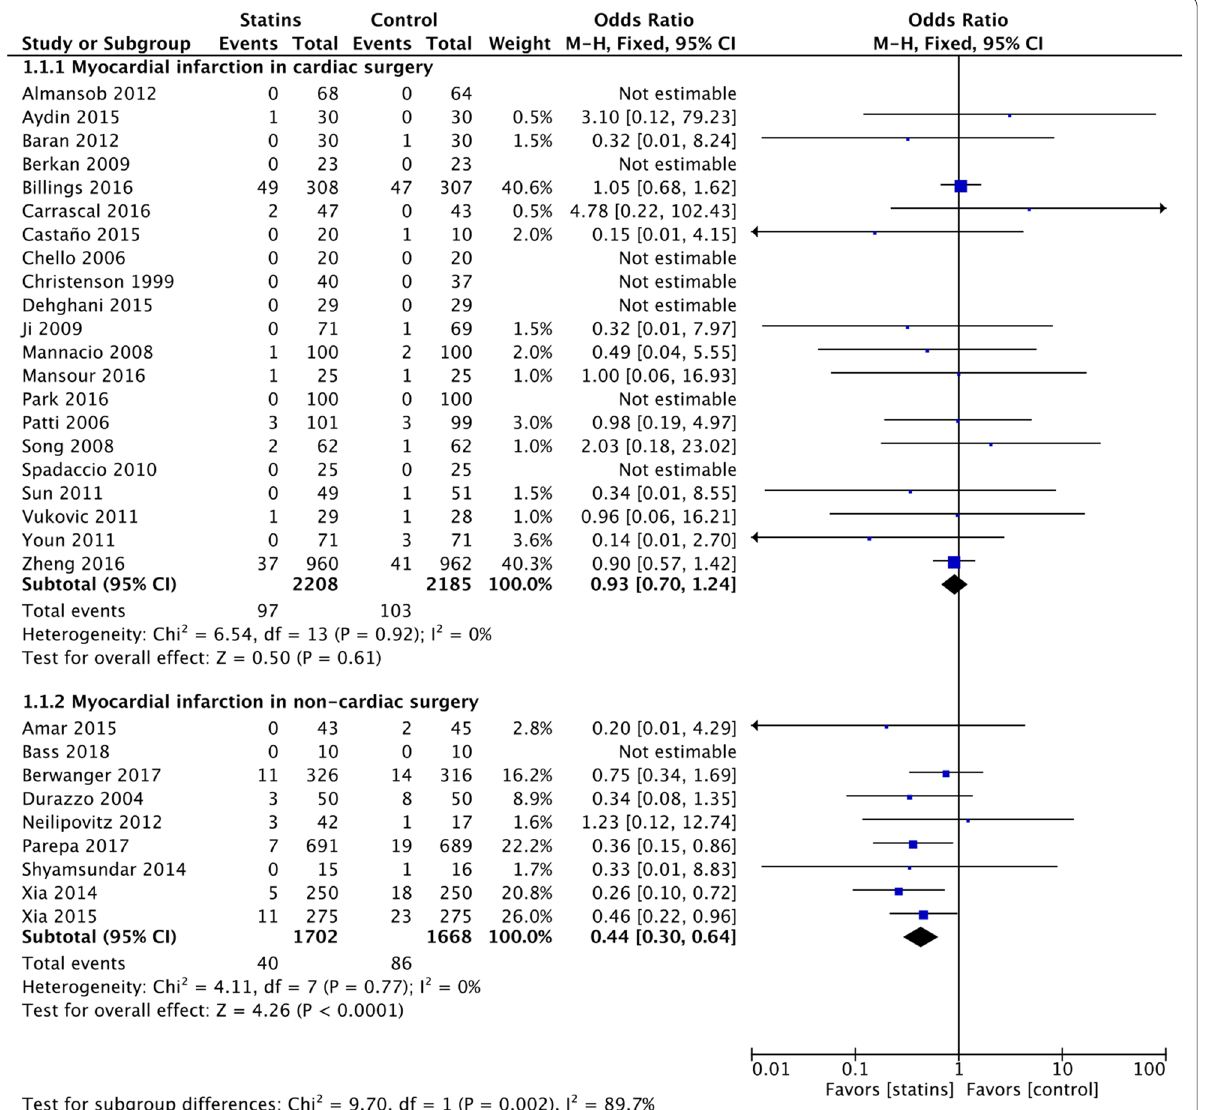
Fig. 3 Postoperative myocardial infarction (MI). Forest plot for postoperative MI in patients with perioperative statin therapy versus